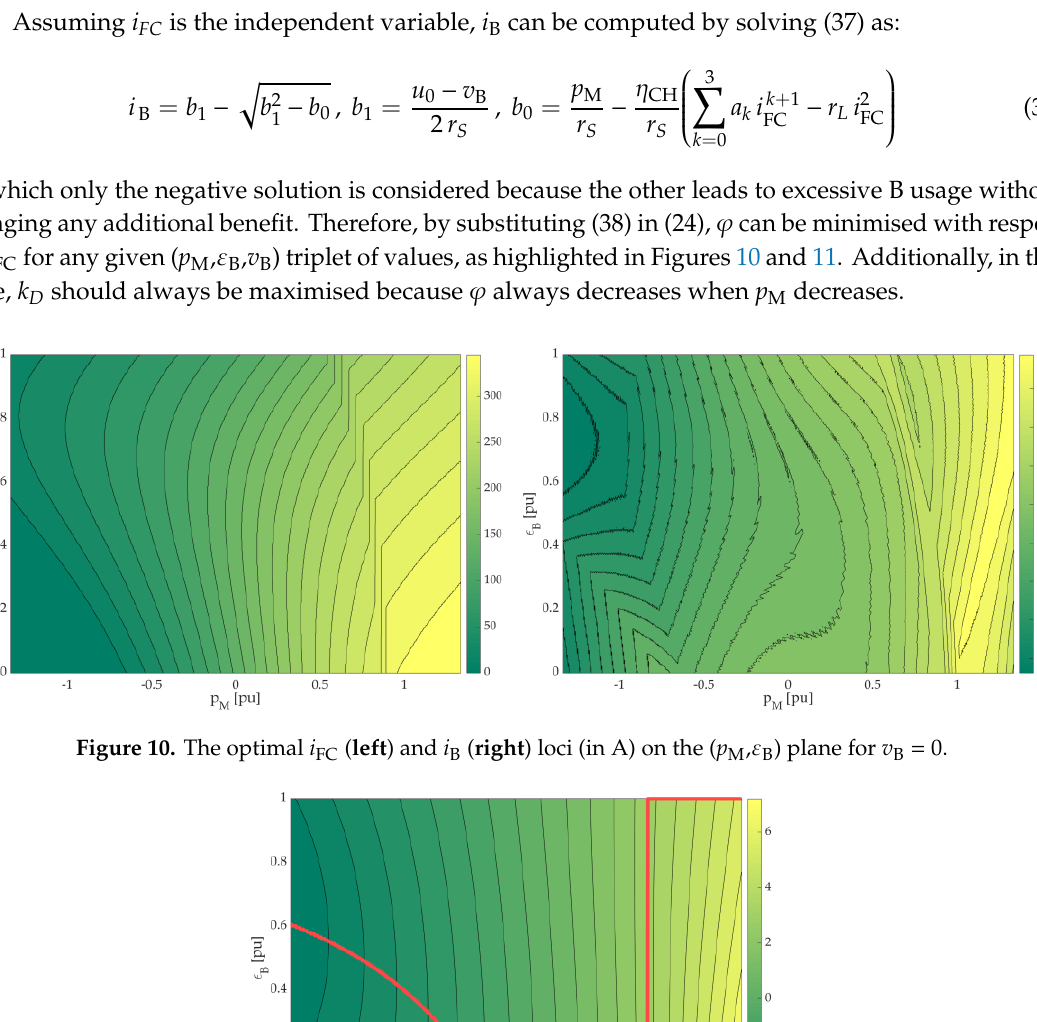
Figure 11. Optimal φ locus (in $/h) on the ( p M , ε B ) plane and optimal ( p M , ε B ) trajectory (in red, v B = 0).